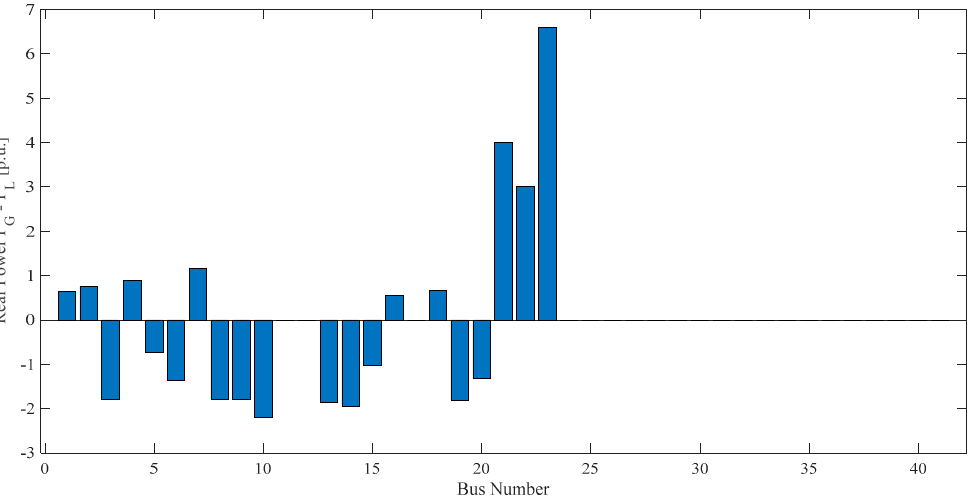
Figure 8. Real power output of the compensated Nigerian 41 bus transmission network with IPFC.